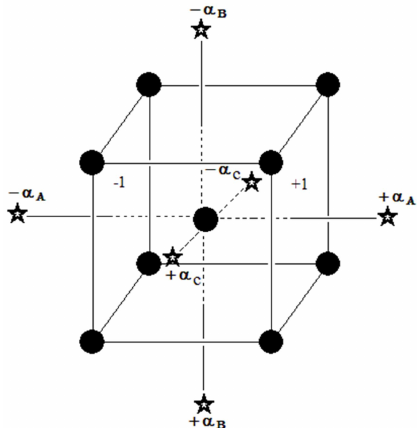
Fig. 1. Central composite design for three